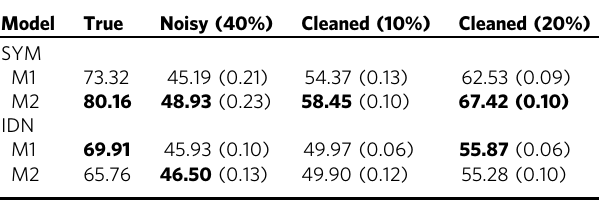
Table 2 Classi fi cation accuracy under noisy evaluation